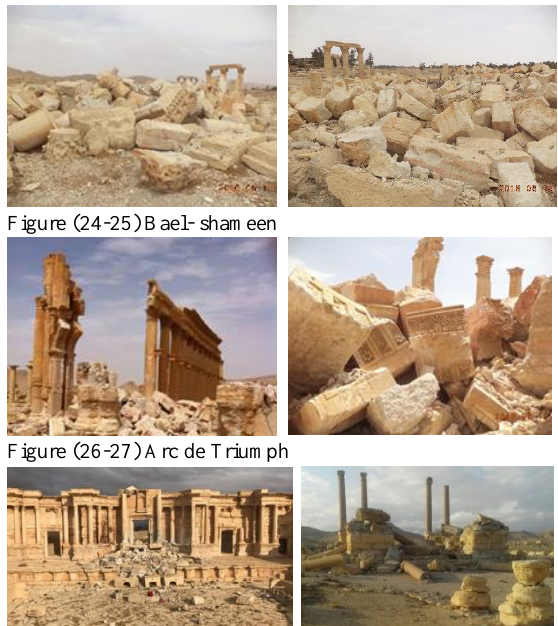
Figure (28-29)the damaged Stage, Figure( )the damaged Tetrapylyon